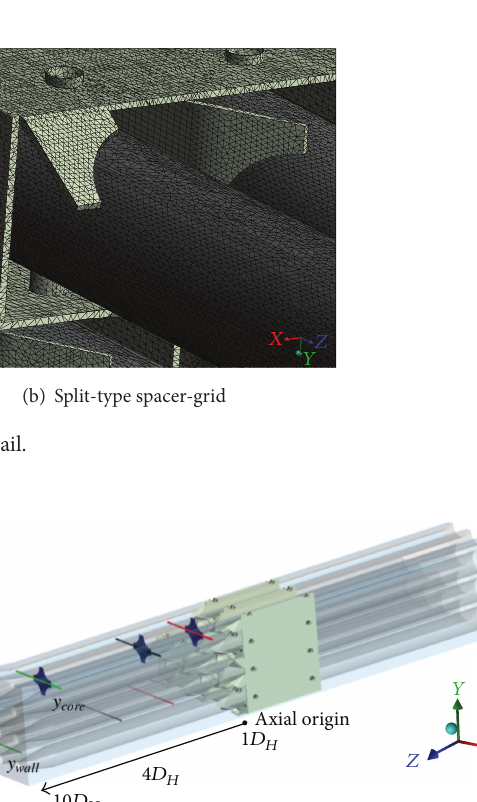
Figure 12: Local effects on the streamwise velocity.